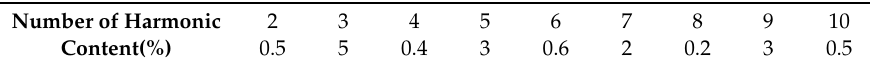
Table 1. Some harmonic parameters except the fundamental wave in the power grid.